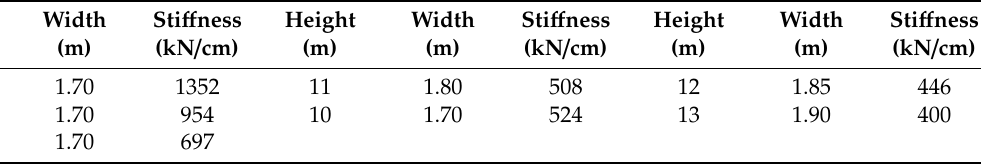
Table 8. Linear sti ff ness of a bridge pier.